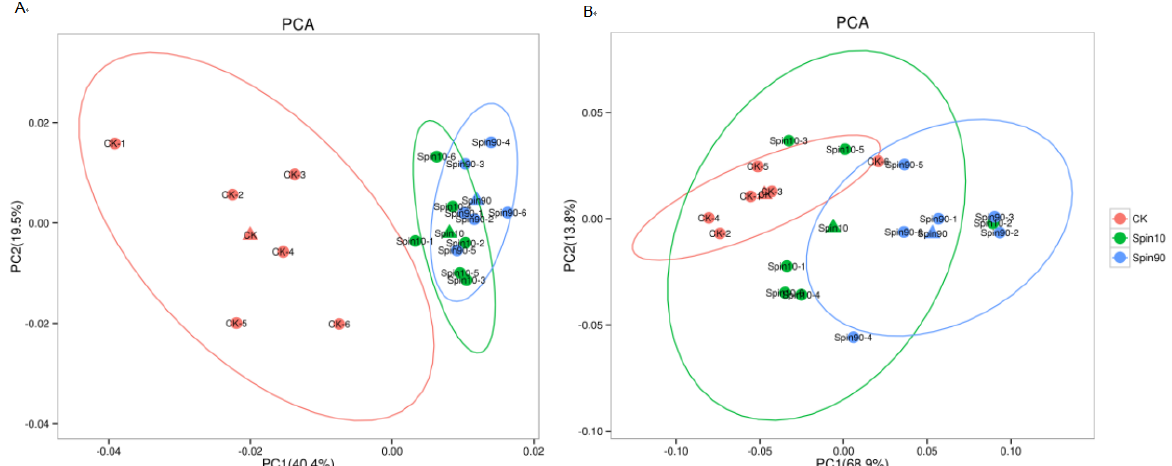
Figure 2. Metabolic profile in S. frugiperda exposed to sublethal and lethal dose of the spinetoram. ( A ) Principal component analysis (PCA) model of Spin10, Spin 90, and Control at pro-model, ( B ) partial least squares-discriminant analysis (PLS-DA) model of Spin10, Spin90, and Control at neg-model.